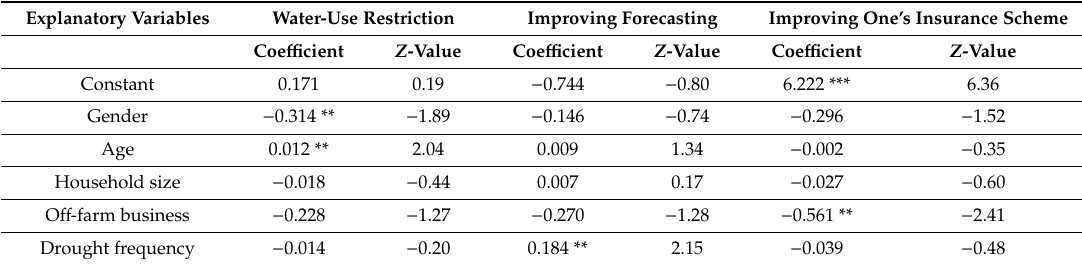
Table 5. Estimates of the multinomial probit model on the choices of e ff ective adaptation strategies